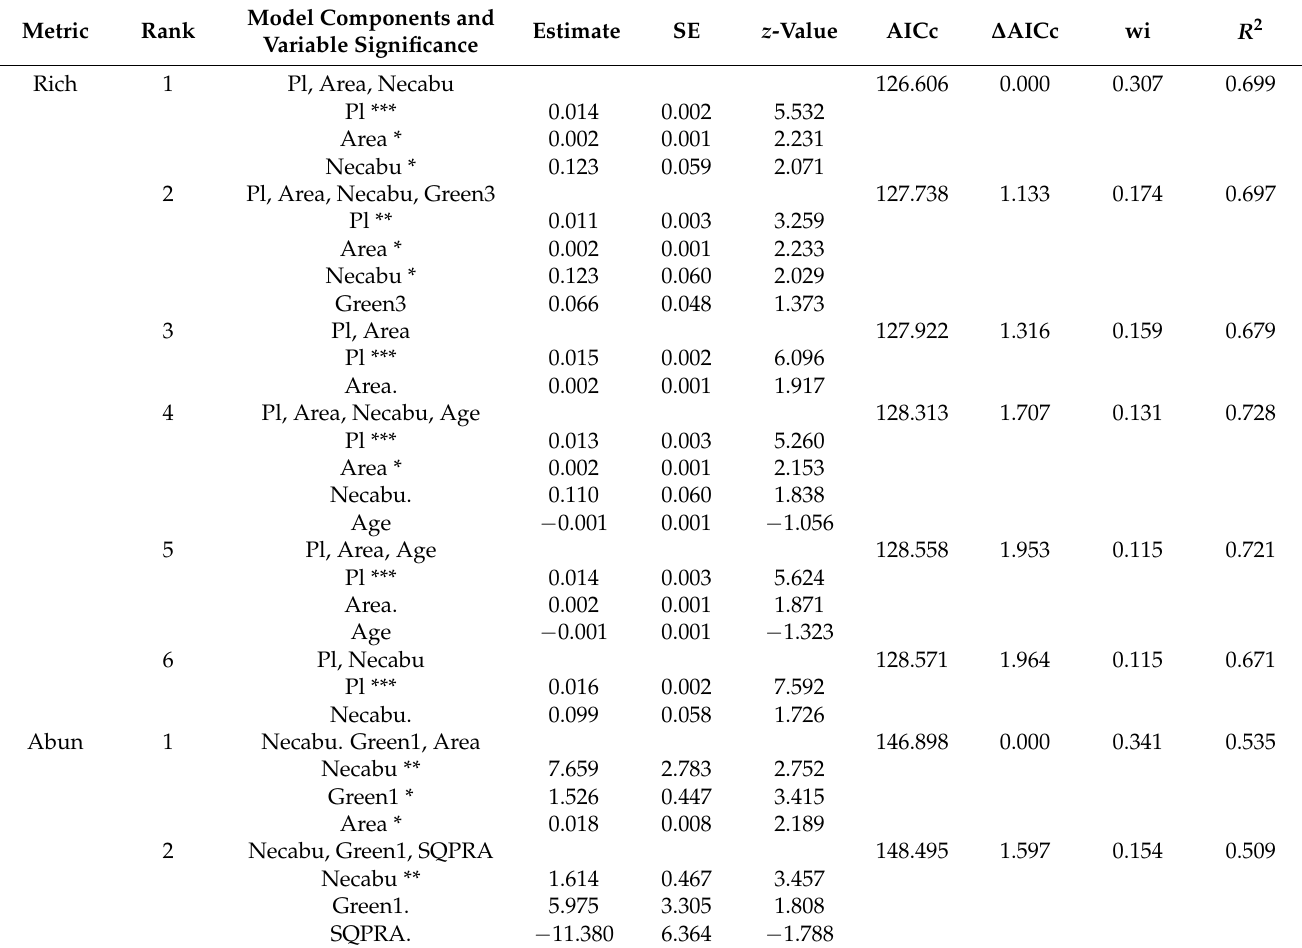
Table 4. Best-ranked Generalised linear models (GLMs) for evaluating butterfly species richness (Rich) and abundance (Abun) in urban parks of Beijing, using the AIC corrected for small sample sizes (AICc), the differences in AICc ( ∆ AICc = AICci − AICcbest) and model’s Akaike weight (wi). Only models with ∆ AICc < 2 were considered in model averaging. The coefficients of determination ( R 2 ) of the models are also shown. Significant variables for each model and variables are marked as ‘***’: p < 0.001, ‘**’: p < 0.01, ‘*’: p < 0.05 and ‘.’ p < 0.1. The explanatory variables presented in the best models are plant species richness (Pl), park area (Area), flowering abundance of nectar plants (Necabu), park completion time (Age), the perimeter/area ratio of each park (SQPRA), the proportion of green space cover within 50 m of the park boundary (Green1) and the PCA axis explaining the highest variation in the proportion of green space cover within 1000 m, 2000 m and 3000 m from the park boundary